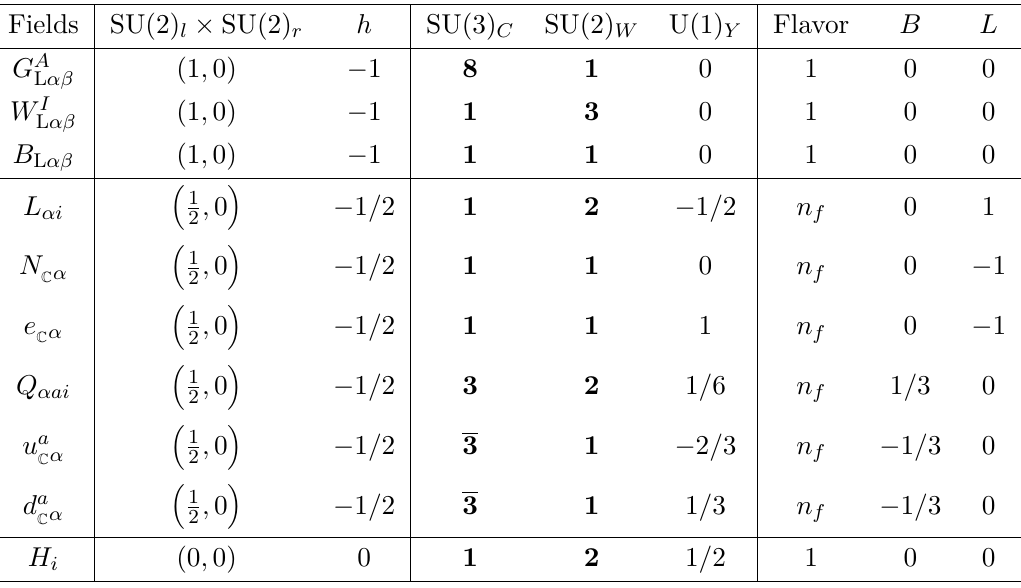
Table 1 . The field content of the ν SMEFT, along with their representations under the Lorentz and gauge symmetries, where N Lorentz group is denoted by ( j number of fermion flavors is denoted as n baryon number B and lepton number L are also listed. All of the fields are accompanied with their Hermitian conjugates that are omitted, ( F fermions, and H † for the Higgs, which are under the conjugate representations of all the groups.